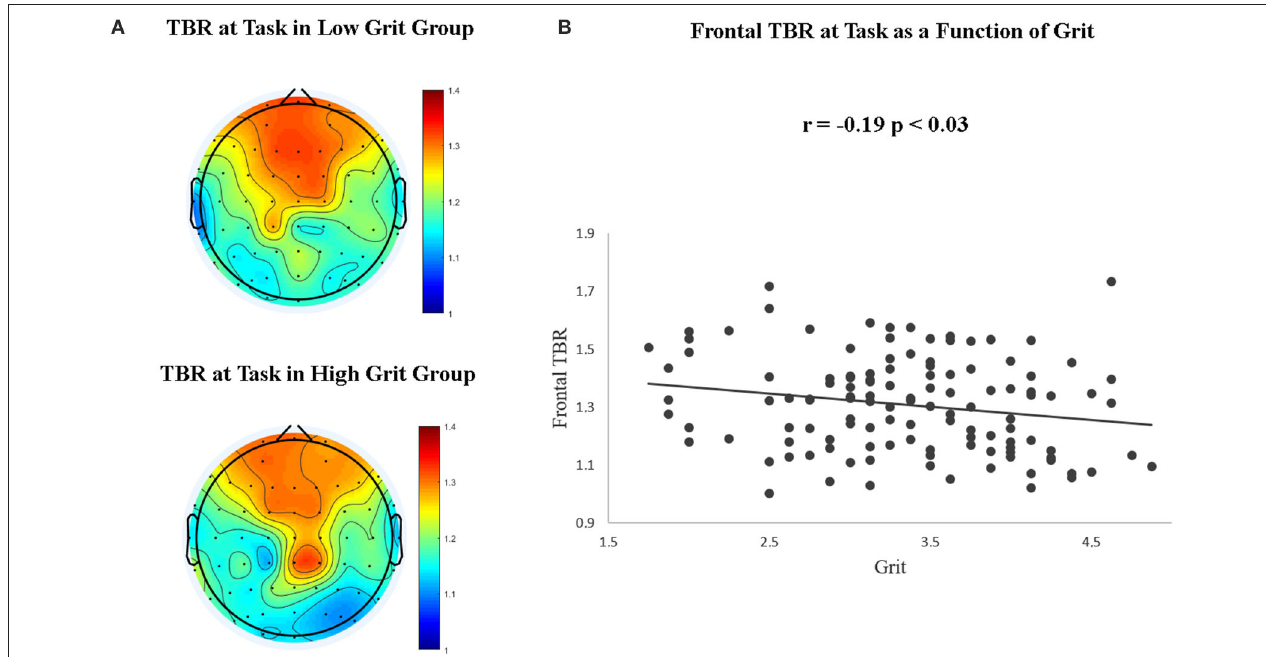
FIGURE 1 | Topographical distribution of the TBR index during task performance as function of the grit group, calculated as 1 SD from the mean (A) , and frontal TBR as a function of grit continuous scores (B) .